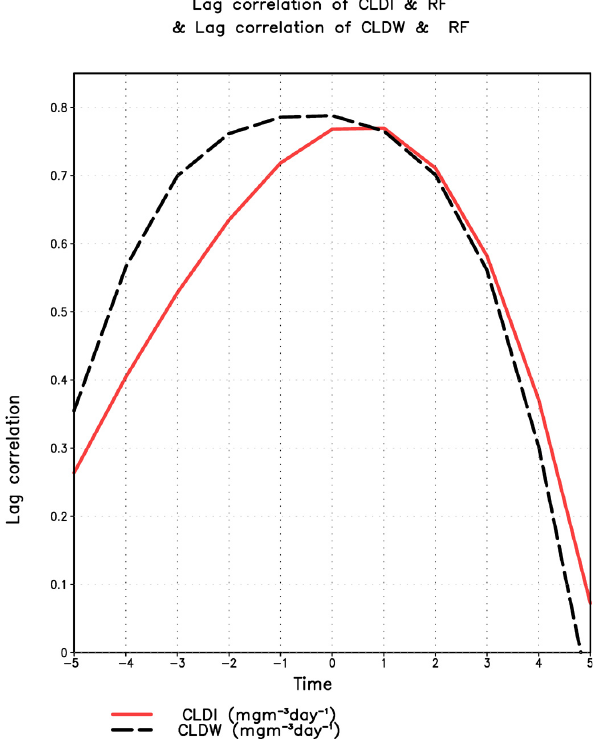
Fig. 16. Domain averaged lag correlation of cloud water (CLDW) and cloud ice (CLDI) with respect to